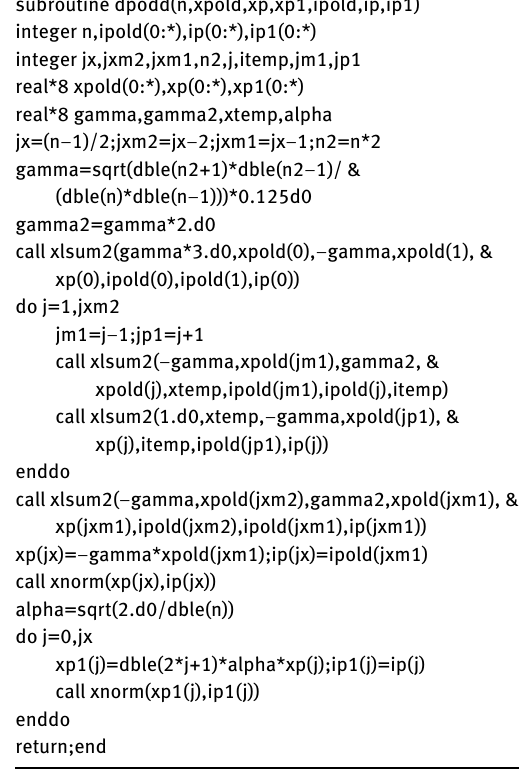
Table 5: Fortran subroutine to return P nnj and P n , n −1, j when n is odd and n ≥ 5 . Same as Table 4 but when n is odd and n ≥ 5